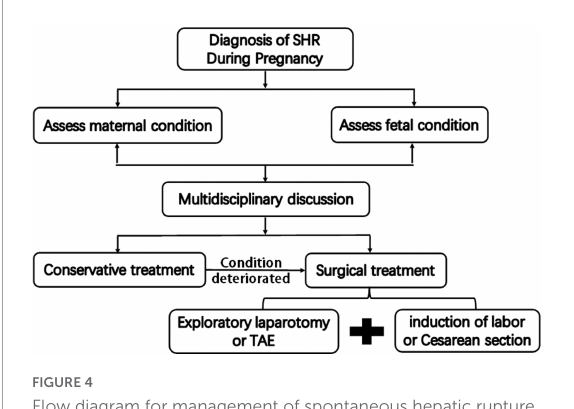
FIGURE4 Flow diagram for management of spontaneous hepatic rupture during